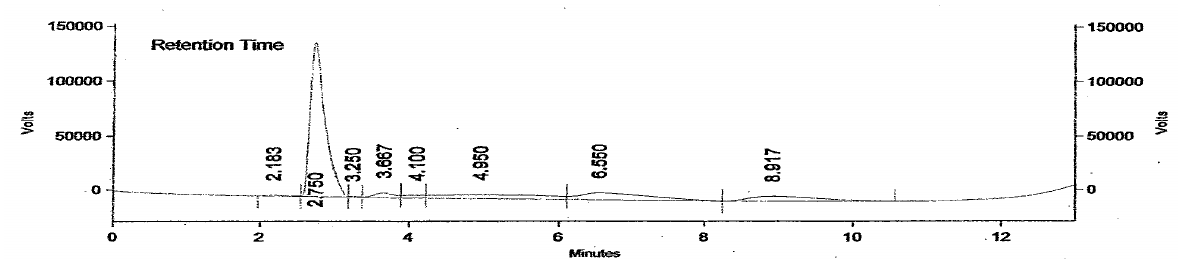
Figure 8: HPLC analysis of F3 of butanol extract of Cynaria scolymus of Pharmacy College Baghdad University. Fraction of the column №